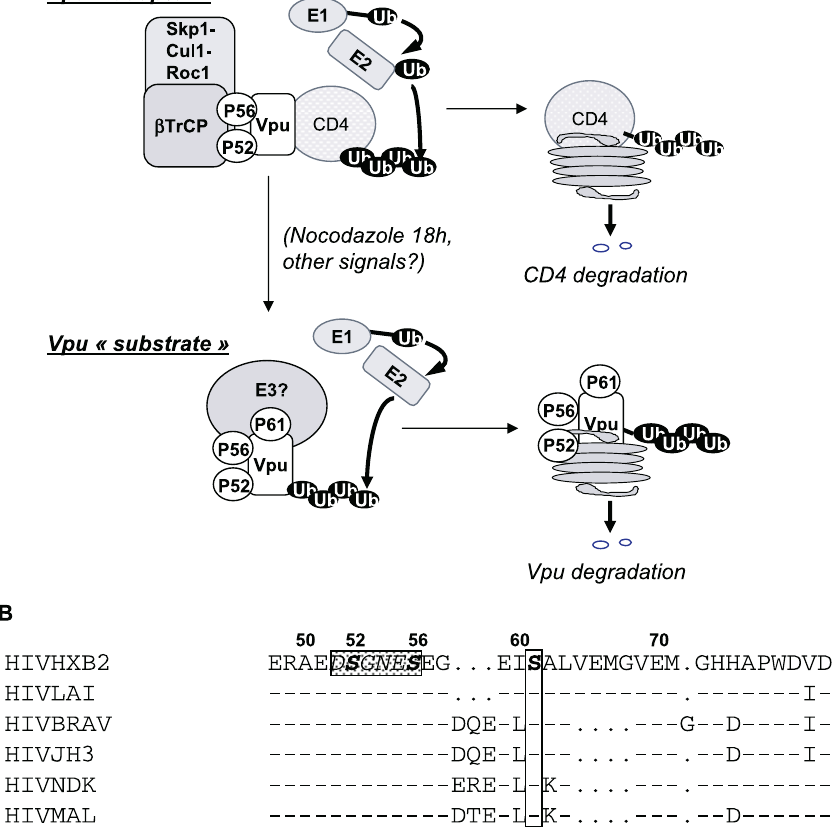
Figure 6. Model for Vpu